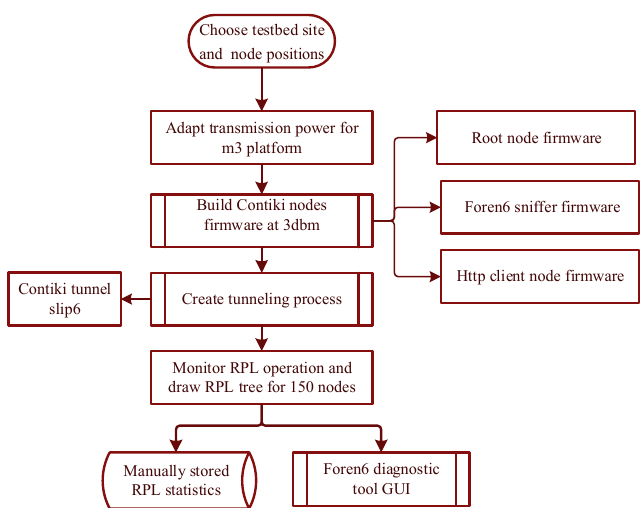
Figure 5. IoT‐LAB testbed RPL experiment steps. Figure 5. IoT-LAB testbed RPL experiment